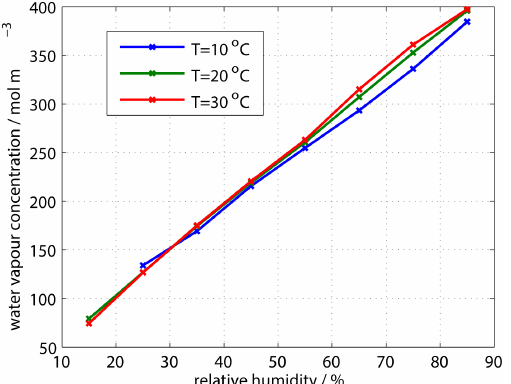
Figure 3. Calibration of a P14 Rapid humidity sensor. Calibration was done at three different temperatures.